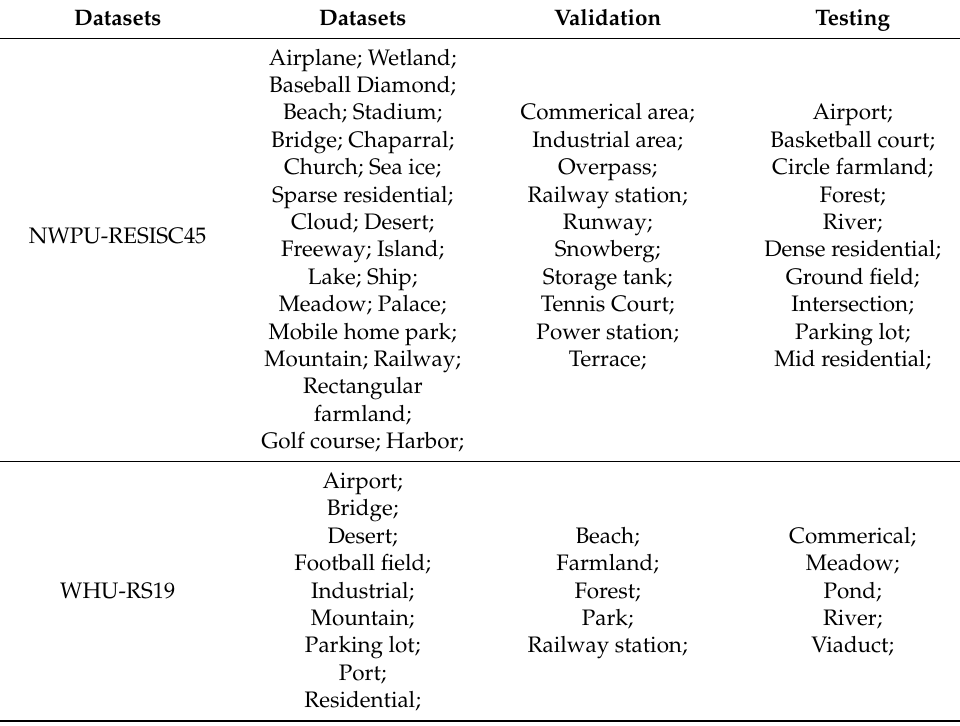
Table 1. Details of NWPU-RESISC45 dataset and WHU-RS19